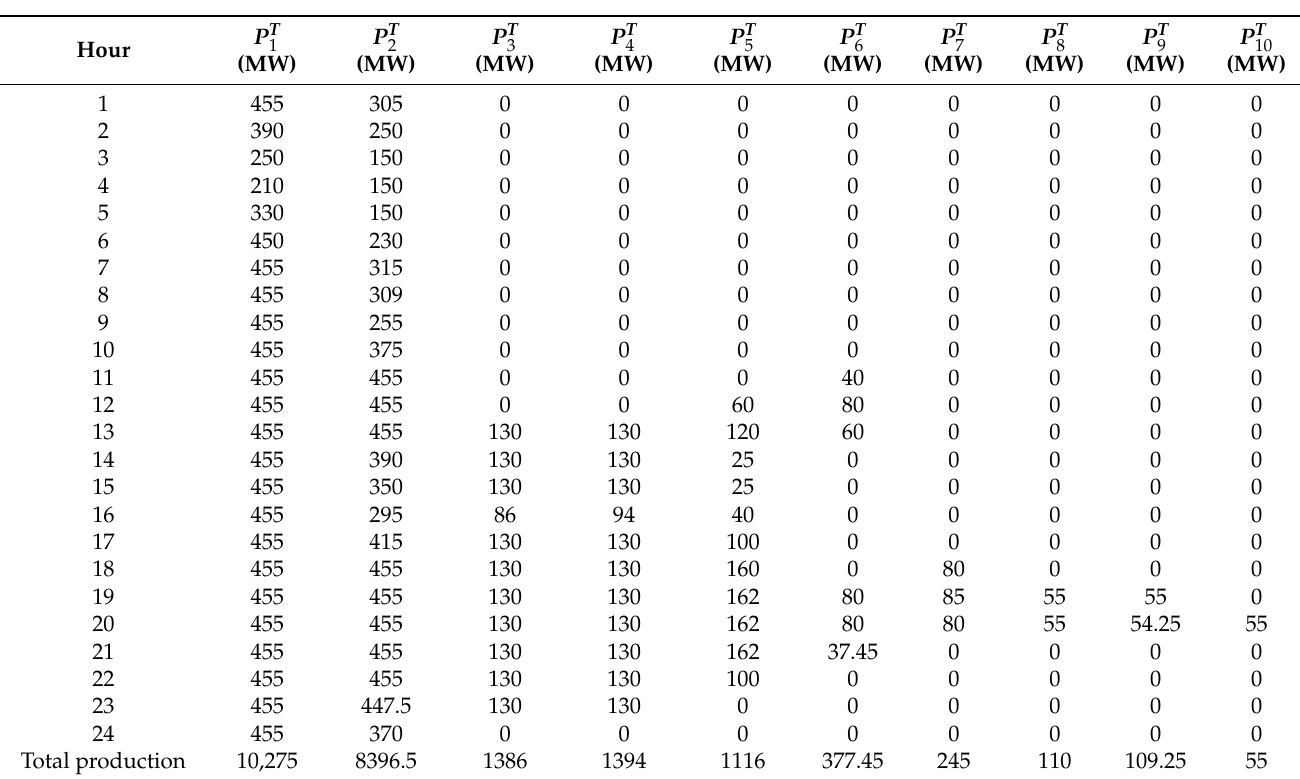
Table A3. Optimal operation scheduling for the conventional thermal units in case 3.